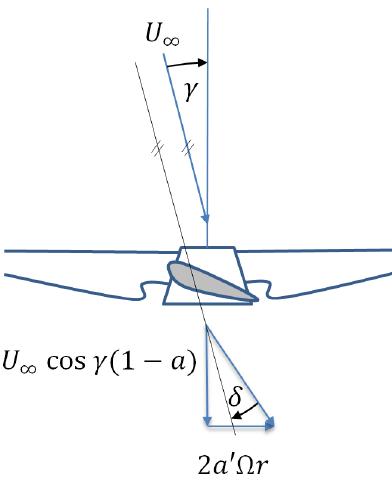
Figure 9. Illustration of the flow components behind the rotor with an axial flow a and tangential flow a (cid:48) induction factor, where (cid:127) is the rotor speed and r the local blade